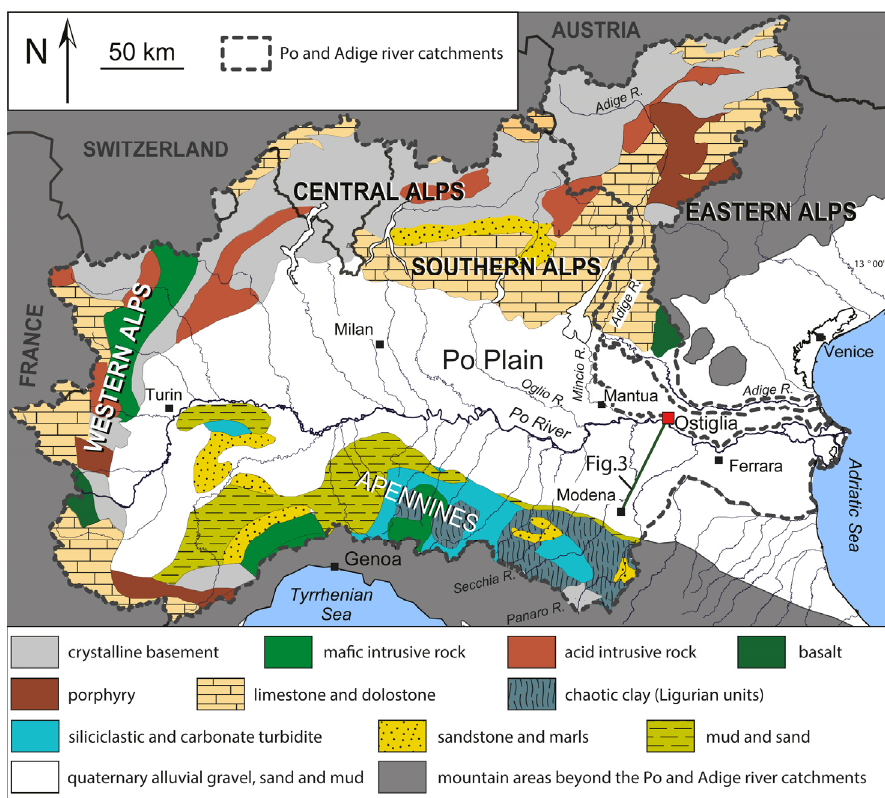
Figure 1. Lithological map of the Po and Adige river catchments. Lithological units cropping out in the drainage basin of the Po and Adige rivers (modified after